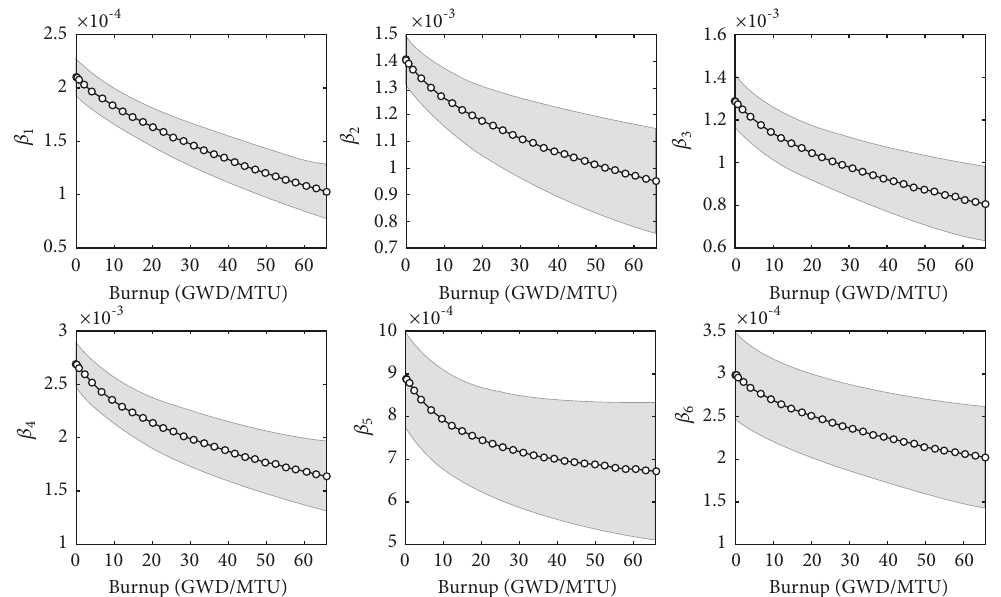
Figure 6: Variation of the precursor-group-wise DNF ( 𝛽 𝑖 ) as a function of burnup plus 1𝜎 uncertainty for the PWR lattice.